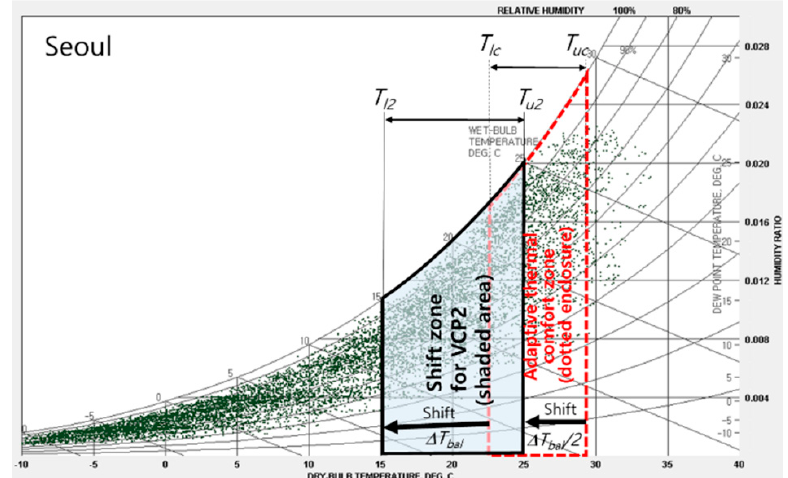
Figure 2. Shift zone for ventilative cooling potential (VCP 2 ) and adaptive thermal comfort zone along